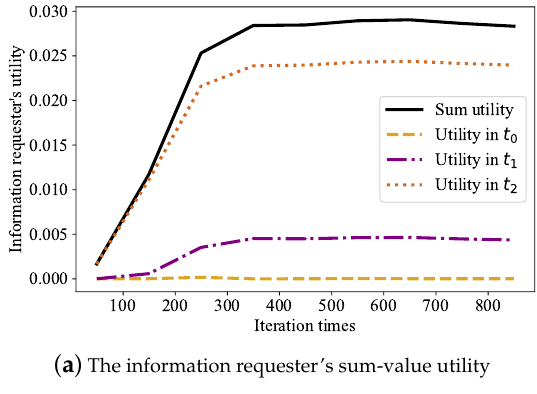
( b ) Time allocation strategy t Figure 8.